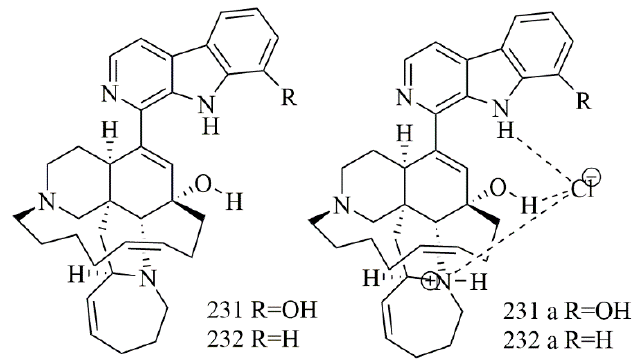
Figure 18. Manzamine alkaloid structures isolated from sponges. Table 18. Cytotoxic activity of manzamine alkaloids.